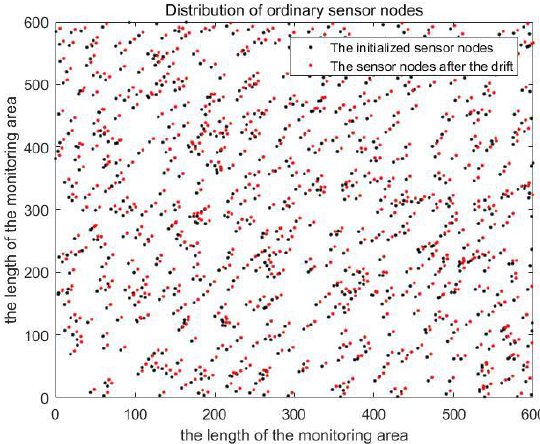
Figure 11. Distribution of ordinary sensor nodes before and after drifting on the projection plane.